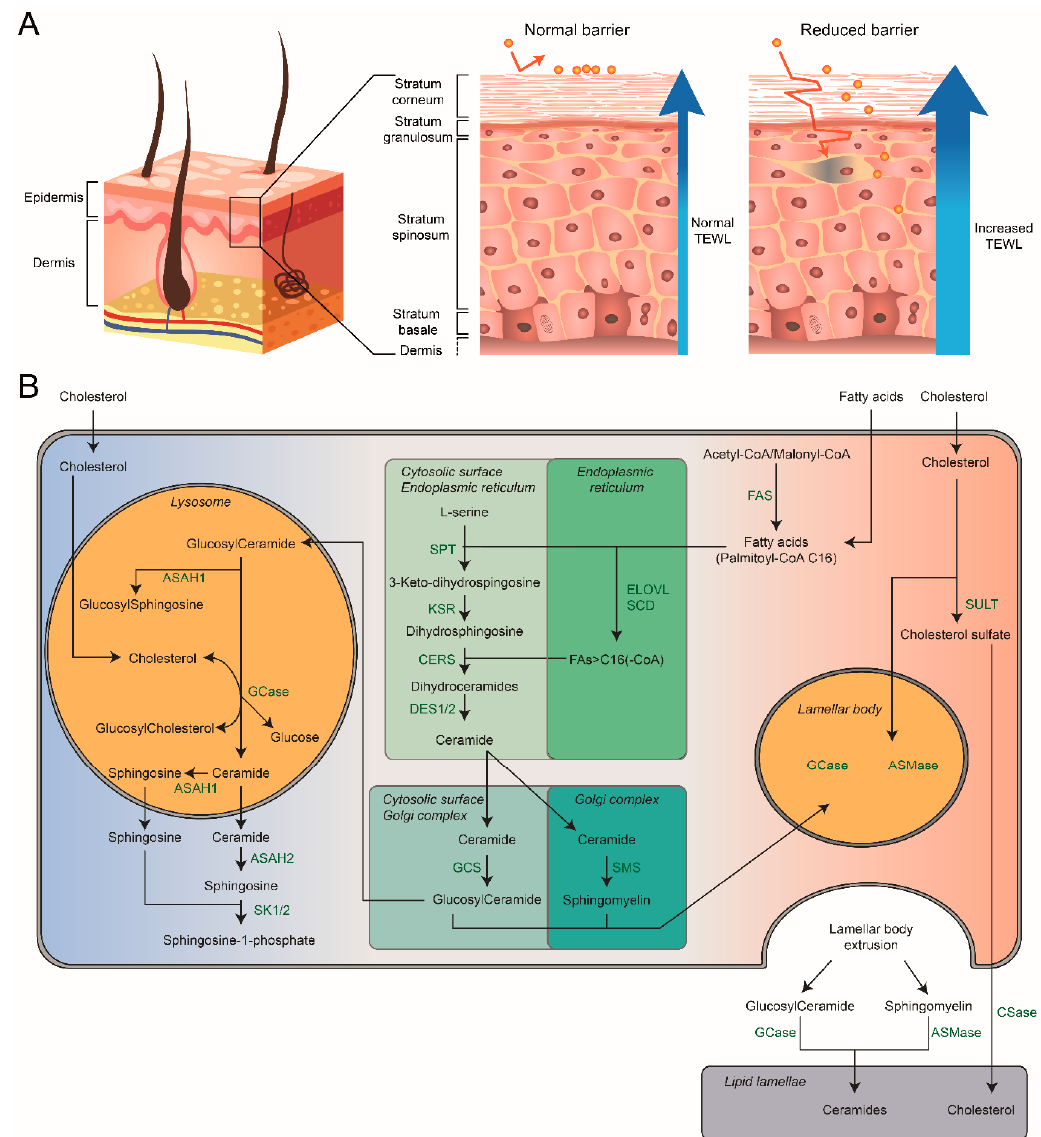
Figure 2. Schematic overview of the human skin and the main processes involved around GCase and its related lipids. ( A ) Schematic overview of a cross section of the skin showing the epidermis, dermis and subcutaneous tissue. The middle illustration shows a more detailed view of the epidermis under healthy conditions. The right illustration depicts a more detailed view of the epidermis with a reduced barrier. Exogenous compounds can get into deeper layers of the epidermis when the barrier is reduced, resulting in an immune response. It also leads to an increased transepidermal water loss (TEWL). ( B ) Schematic overview of the main processes involved around GCase within the cell. Arrows indicate the transport or conversion of lipids; associated enzymes are listed adjacent to their abbreviations.